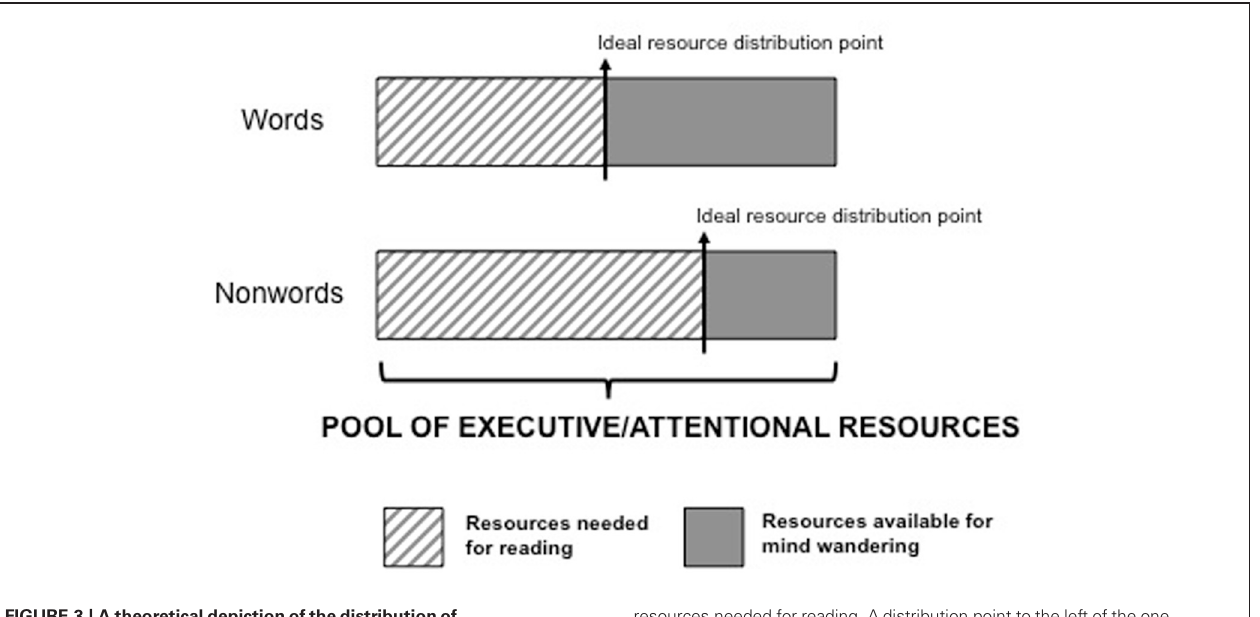
FIGURE 3 | A theoretical depictionofthedistributionof executive/attentional resources inthewordreadingand non-word readingconditionsofExperiment1. Theidealdistribution point isshown; the point at which mind wandering ismaximized without impinging on